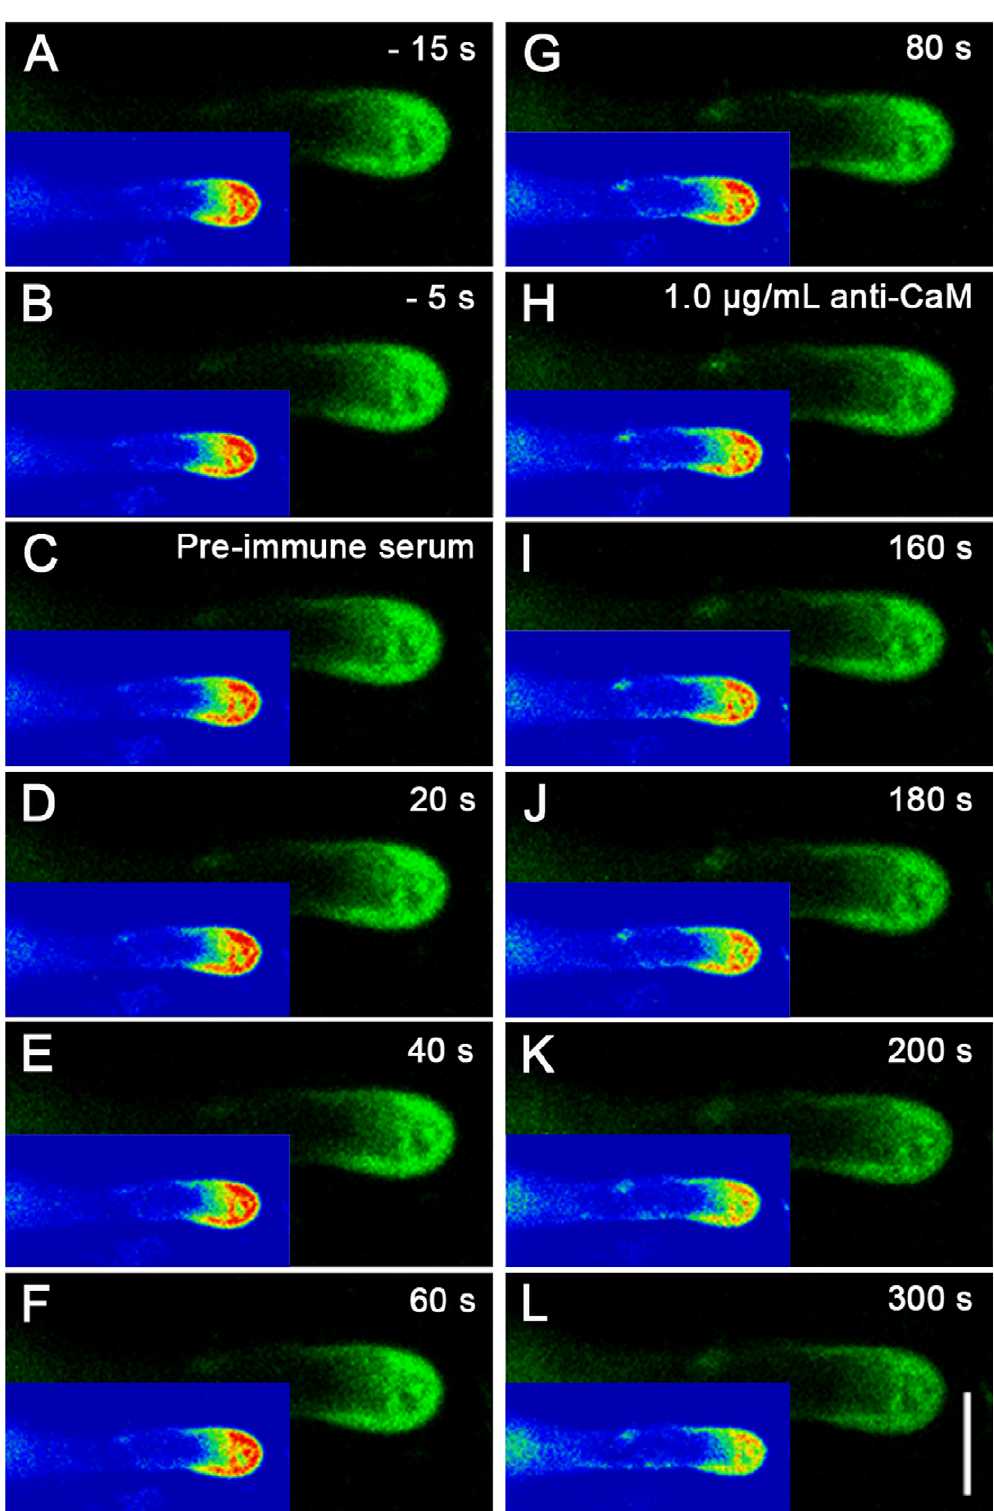
Figure 3. Time course analysis of [Ca 2 + ] c changes upon anti-CaM treatment. Calcium Green-1 Dextran microinjection was carried out to further elucidate changes in calcium gradient upon addition of anti-CaM. Calcium Green-1 dextran (2.5 mM in 5 mM HEPES buffer, pH 7.0) was pressure-injected into pollen tubes. Ca 2 + dynamics in injected pollen tubes were recorded using a LSM 510 META LSCM (Zeiss Co., Germany) in time- course mode (488 nm excitation laser and 525/550 nm band pass emission filter). A–B, Before time-series recording, two single images were captured at 10-s interval to examine fluorescence. C–G, Ca 2 + distribution in injected pollen tubes did not change significantly after application of pre-immune serum at 0 s. H–L, Ca 2 + gradient dissipated after addition of 1.0 m g/mL anti-CaM at 100 s during time-course recording. Corresponding rainbow mode